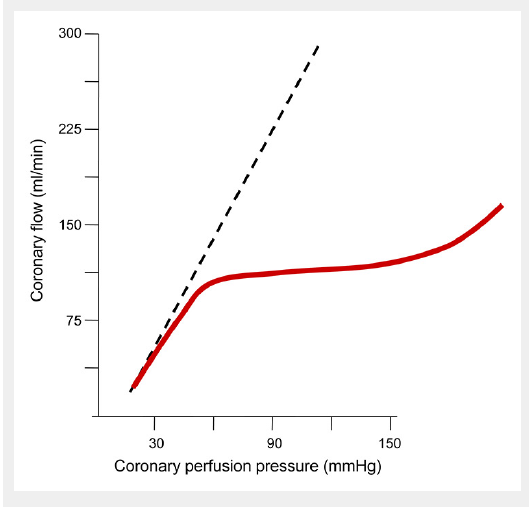
Schematic illustration of autoregulation of coronary blood flow, which is constant at around 1 ml/min over a wide range of perfusion pressures (red line). During the state of maximum microcirculatory vasodilation (broken line), i.e., minimum resistance, coronary flow varies directly with varying perfusion